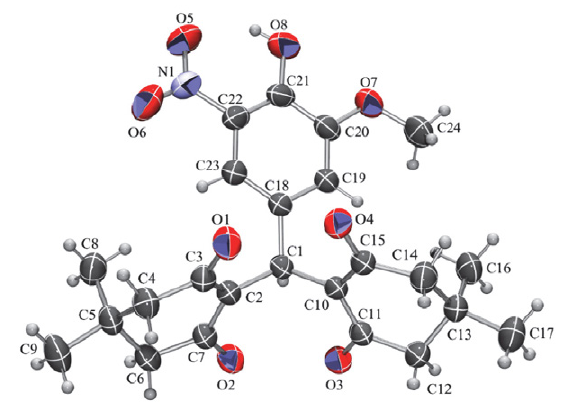
Figure 6. ORTEP-3 drawing of a molecule of 2 with the atom num- bering scheme. Displacement ellipsoids are drawn for the probabil- ity of 50% and hydrogen atoms are shown as spheres of arbitrary radii. Figure 7. Crystal packing of 2 viewed in the direction [010].